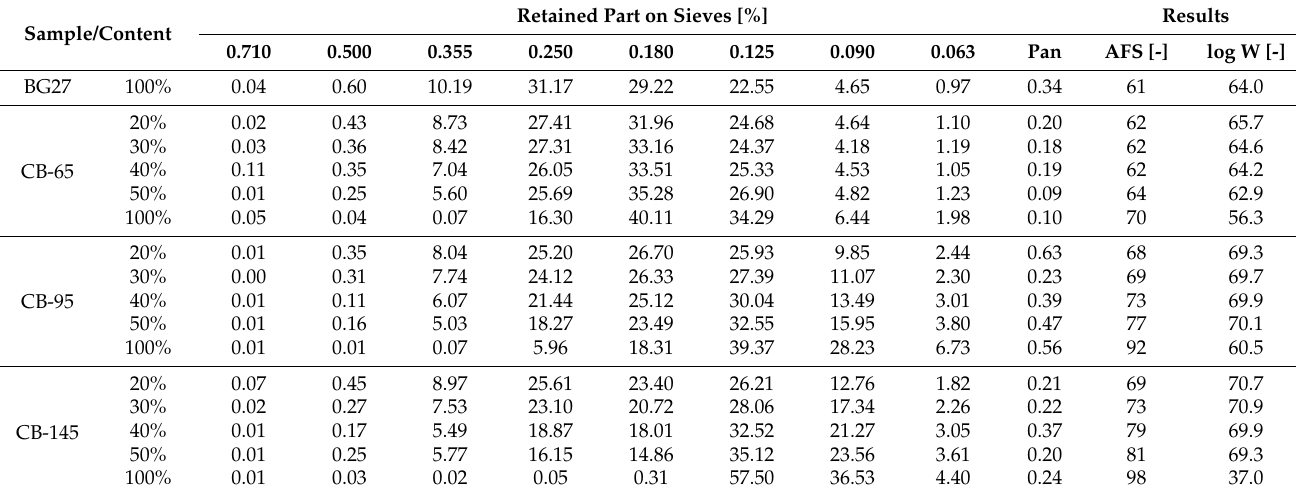
Table 2. Parameters of tested hybrid sand mixtures and particle size distribution.